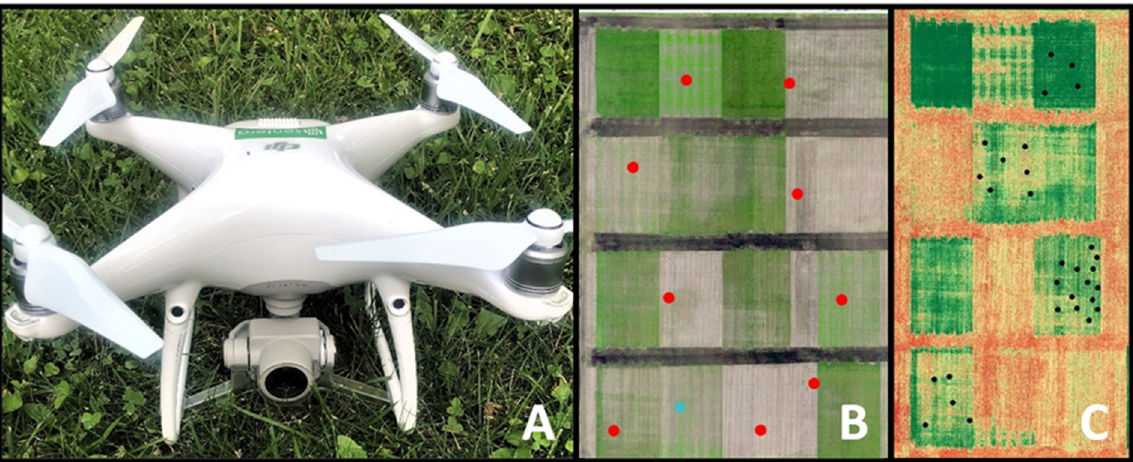
Figure 1. ( A ) The commercial off-the-shelf UAV used in this project was a DJI Phantom 4 Pro equipped with the DJI standard 1-inch 20-megapixel CMOS sensor. ( B ) An example of a final mosaicked RGB image. The red dots indicate the location of ground control points within the field. ( C ) An example of a modified greed red vegetation index (MGRVI) map generated in ArcGIS Pro. The black dots represent ground-truth sampling points. This field included cover crops beyond cereal rye, ground-truth samples were only collected from cereal rye monoculture plots.